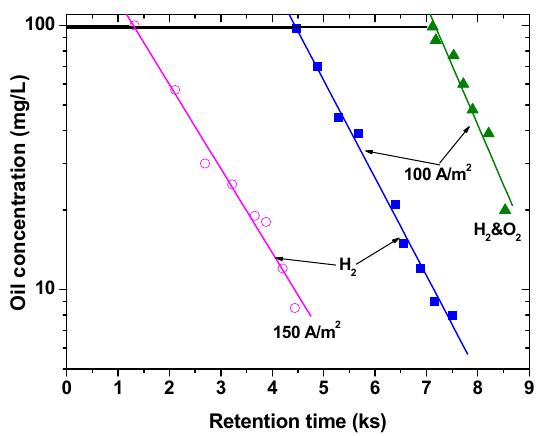
Figure 4. Separating the electrodes, with a membrane (at different current densities): Testing with an oil–water emulsion. Reprinted with permission; copyright Taylor & Francis [50].